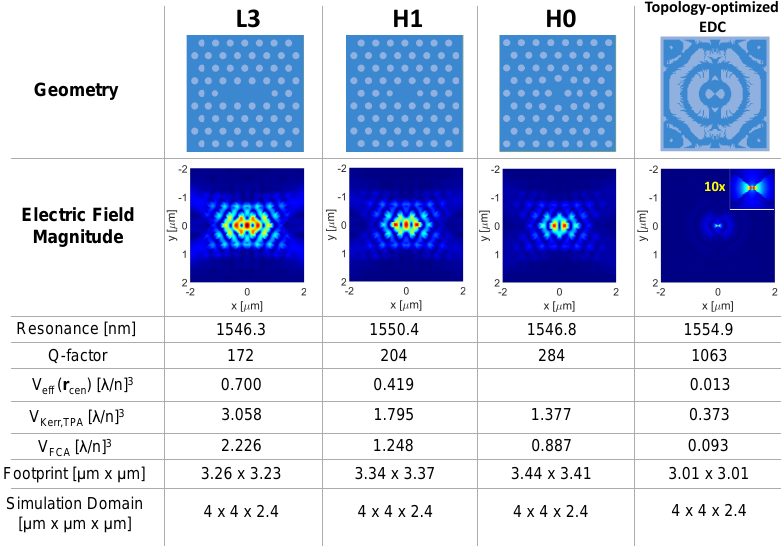
Figure 4. Comparison of three photonic crystal cavities (respectively, L3, H1 and H0) and a cavity for extreme dielectric confinement (EDC) designed by topology optimization. All cavities are made of InP and have similar footprint. We notice, though, that the Q-factors for L3, H1 and H0 may be further optimized by perturbing the holes, as explained earlier. The topology-optimized design was based on that reported in [10], which however has confinement in air. As compared to [10], we added in the center a 10nm × 16nm InP bridge. Calculations have been performed by a three- dimensional finite-difference-time-domain (FDTD) method. The center of the cavity is denoted by r cen . The effective mode volume of the H0 cavity is not reported, since the field had a minimum in the